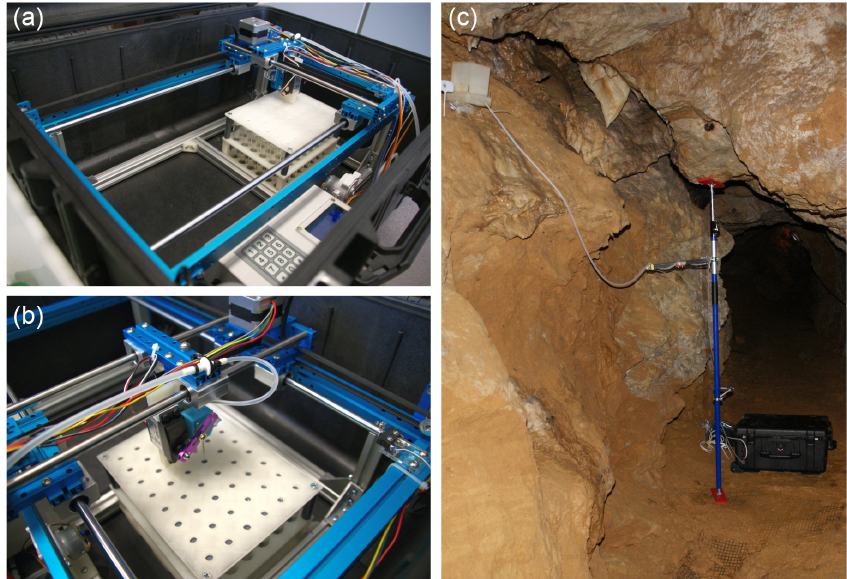
Figure 2. The GUARD automated fluid sampler in detail (a, b) and in operation (c) during a 5-day case study (Sect. 4 carried out in the “Kleine Teufelshöhle” cave in the Franconian Switzerland region, Germany. At a 4h interval, a total of 22 dripwater samples were automatically collected for subsequent analysis of the carbon isotope values ( δ 13 C DIC ) of the dissolved inorganic carbon (DIC).